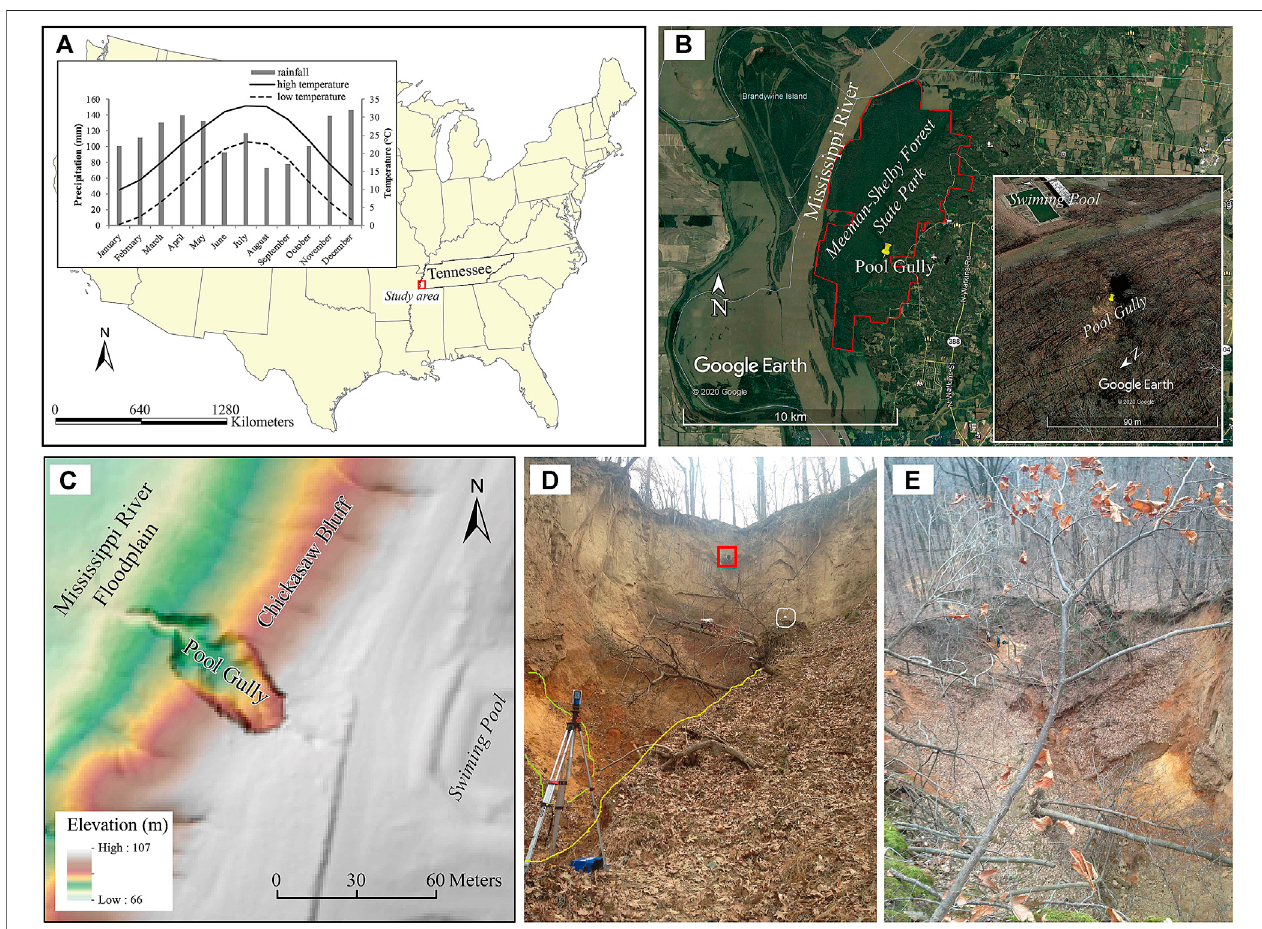
FIGURE 1 | (A, B) The study site within the Meeman-Shelby Forest State Park in west Tennessee. The inset graph in (A) shows monthly average high and low temperature and precipitation (1981 – 2010) for Shelby County, Tennessee (U.S. Climate Data, 2016). The Google Earth screen shots in (B) are based on the high- resolution images updated in 2020. The red polygon represents the park boundary. The pool gully is close to the swimming pool and is clearly identi fi able on the image. (C) Shaded-relief 1-m DEM showing the Mississippi River fl oodplain and the Chickasaw Bluff with the marked pool gully and the swimming pool in the park. The DEM is generated using the ALS point cloud (0.5 m spacing) surveyed by the USGS in 2012. (D) A fi eld photo facing the gully head. The discharge pipe from the swimmingpoolisvisibleintheredbox atthetopofthephoto. TheTLSandits tripodareattheleft-bottom ofthephoto. Thewhitebox marksaspheretarget fortheTLS scan. The yellow line marked the bottom of the gully and a fresh collapsed slope on the left side of the gully. (E) another fi eld photo facing downslope of the gully. Falling trees and fresh collapsed slopes from these two fi eld photos indicate very active erosion-deposition processes in this gully.